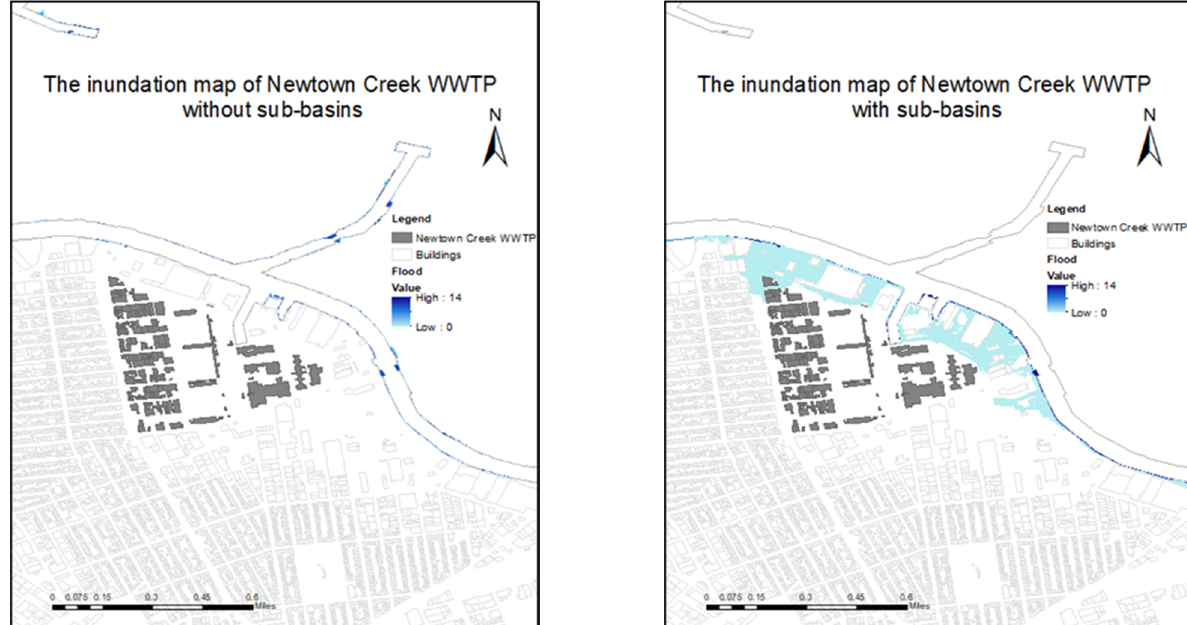
Figure 8. Comparison of inundation map of Newtown Creek WWTP under a 20 min rainfall event without and with